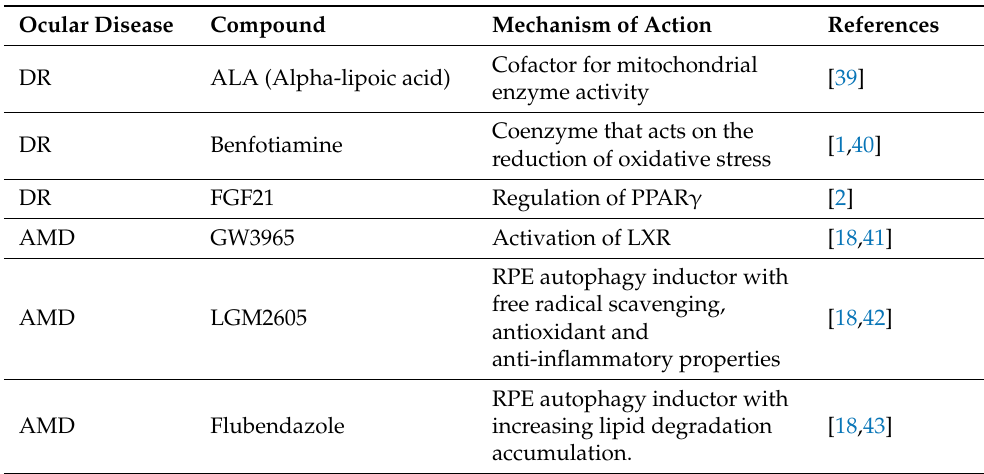
Table 1. Drugs under study for the treatment of metabolic eye diseases (Captions: DR, diabetic retinopathy; AMD, age-related macular